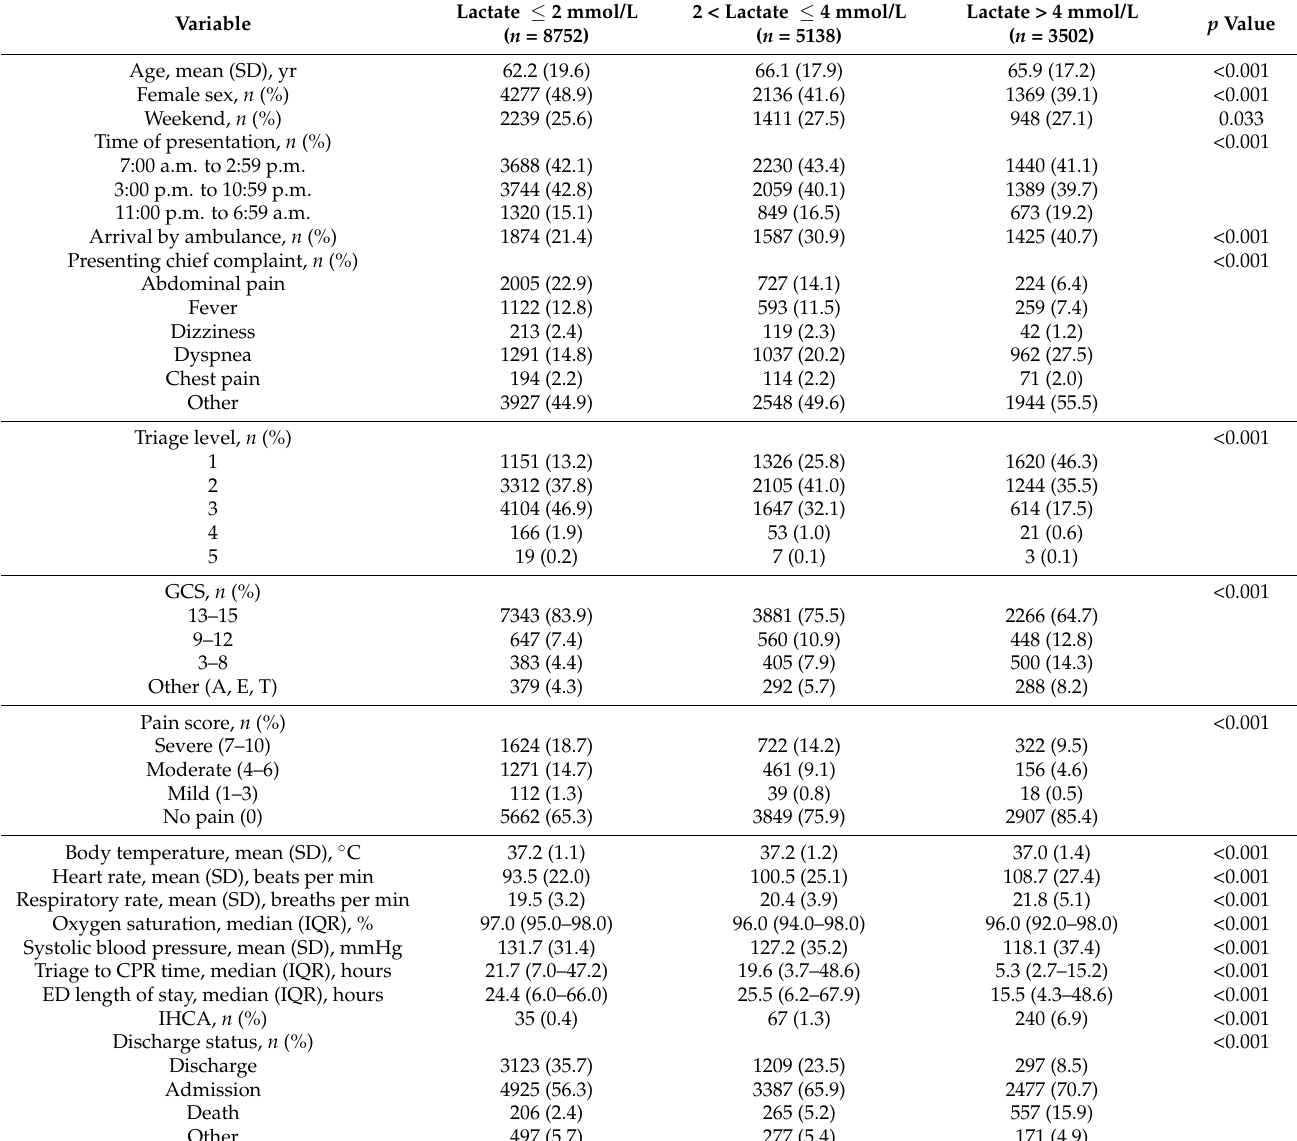
Table 1. Baseline patient characteristics by the lactate